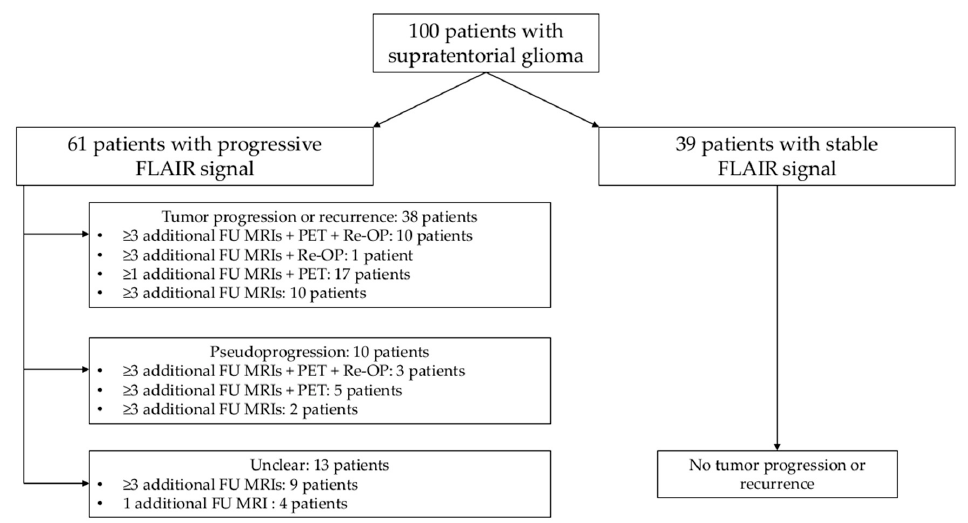
Figure 4. Evaluation of signal changes – progression versus pseudoprogression. This chart shows the number of patients with progressive or stable fluid attenuated inversion recovery (FLAIR)